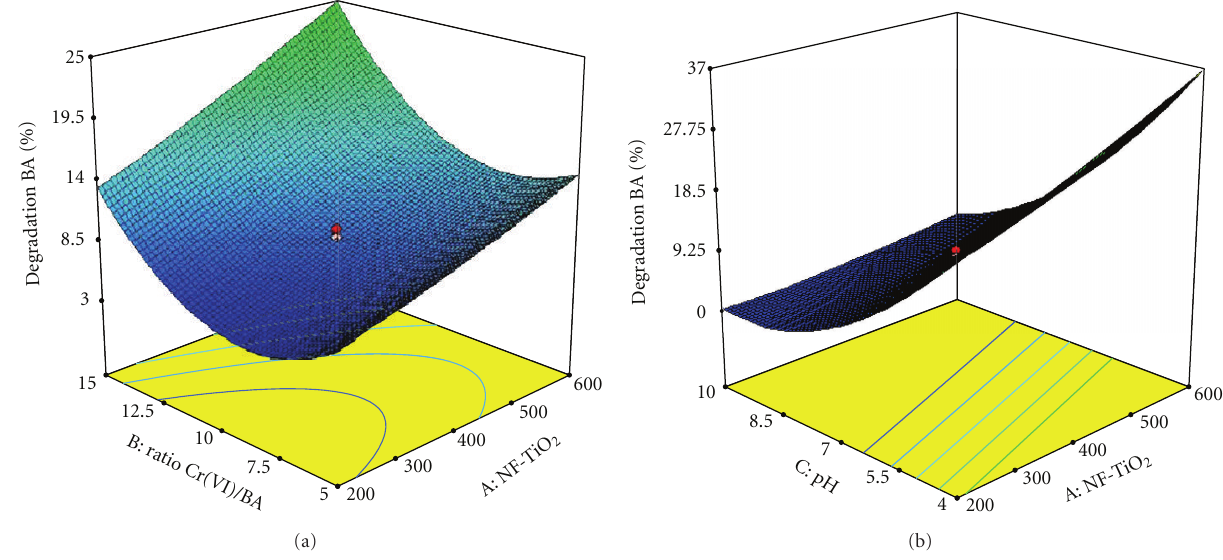
Figure 8: 3D response surface plots for the % BA degradation; (a) as a function of N-F-TiO 2 concentration and Cr(VI)/BA ratio; (b) as a function of pH and N-F-TiO 2 concentration.